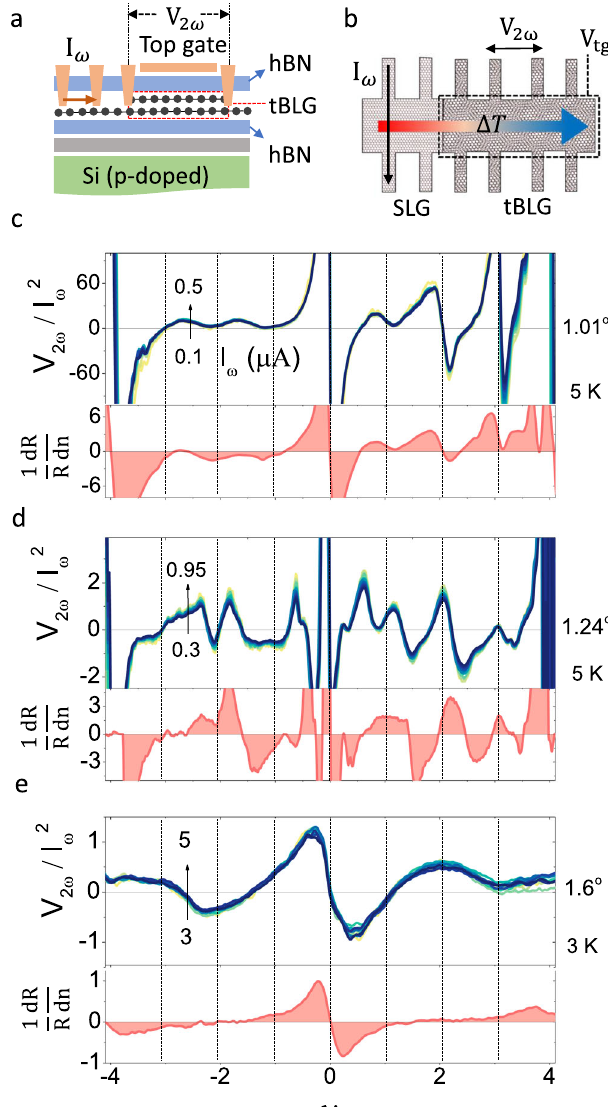
Fig. 2 Thermoelectric transport in twisted bilayer graphene. a The cross- sectional view of the device, showing the constituent layers, electrical contacts, and the gate assembly. b In-plane heating and measurement schematic for thermovoltage V 2 ω in the tBLG region. Density dependence of − 2 × 10 6 ) measured at 5 K for ( c ) θ ≈ 1.01 ∘ , d V = I 2 ω (in the units of VA 2 ω 1.24 ∘ , and at 3 K for ( e ) 1. 6 ∘ device. The different curves in each panel represent the V 2 ω = I 2 ω measured at different I ω . The bottom graphs in each panel show the numerically calculated α = (1/ R )d R /d n (in the units of m 2 ) for